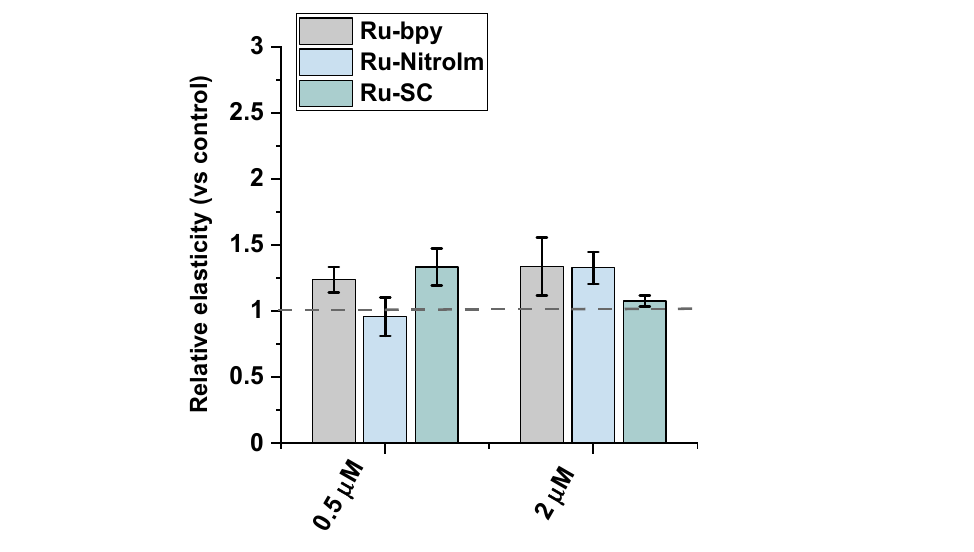
Figure 4. AFM nanomechanical measurements of elasticity presented as a change in Young’s modulus (kPa) of HMEC-1 cells after 24 h treatment with [Ru(dip) 2 (bpy)]Cl 2 (gray), [Ru(dip) 2 (bpy-nitro)]Cl 2 (blue) and Ru(dip) 2 (bpy-SC)]Cl 2 (green) (0.5 or 2 µM). The results were calculated by analyzing ~60 randomly selected Ru-treated adherent cells in respect to control (untreated) cells (dashed line).